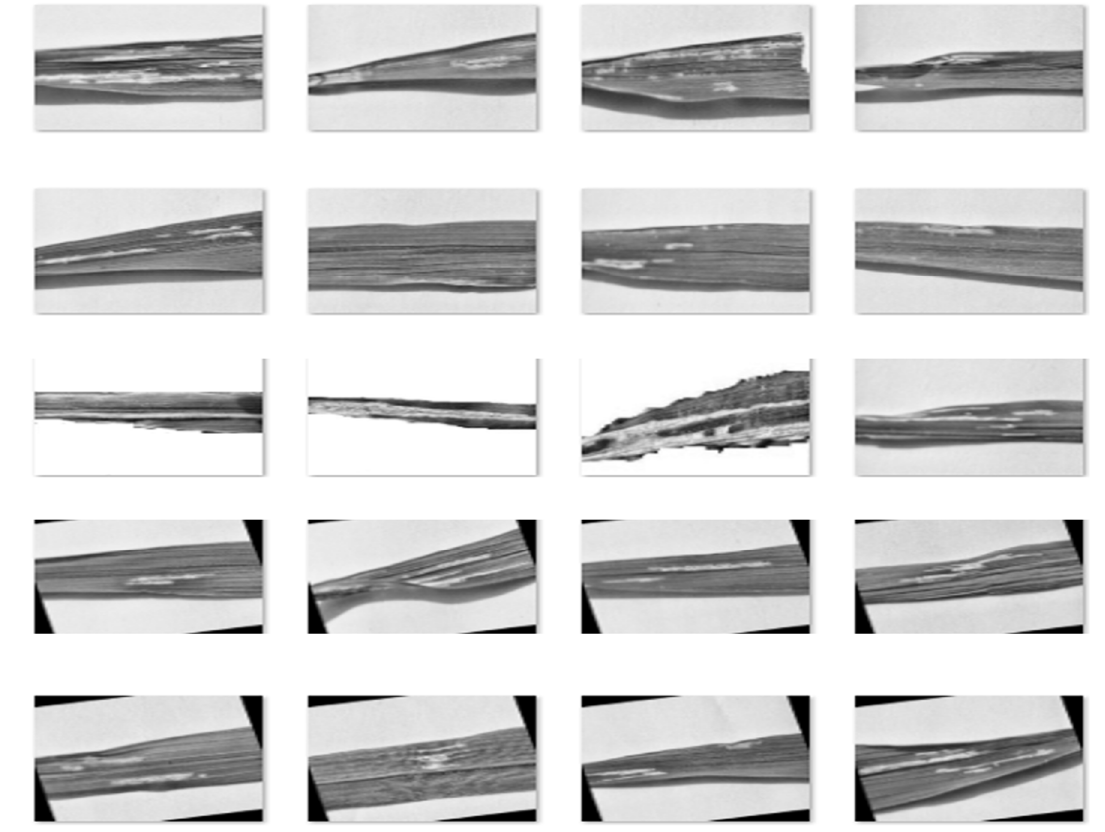
Figure 9. Generated Augmentations For Bilateral Filtering.